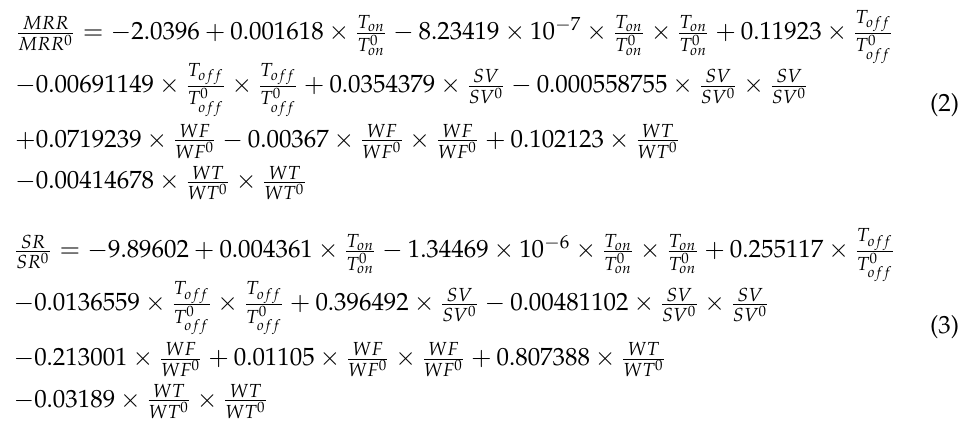
Figure 8. The effect of WT on MRR and SR.